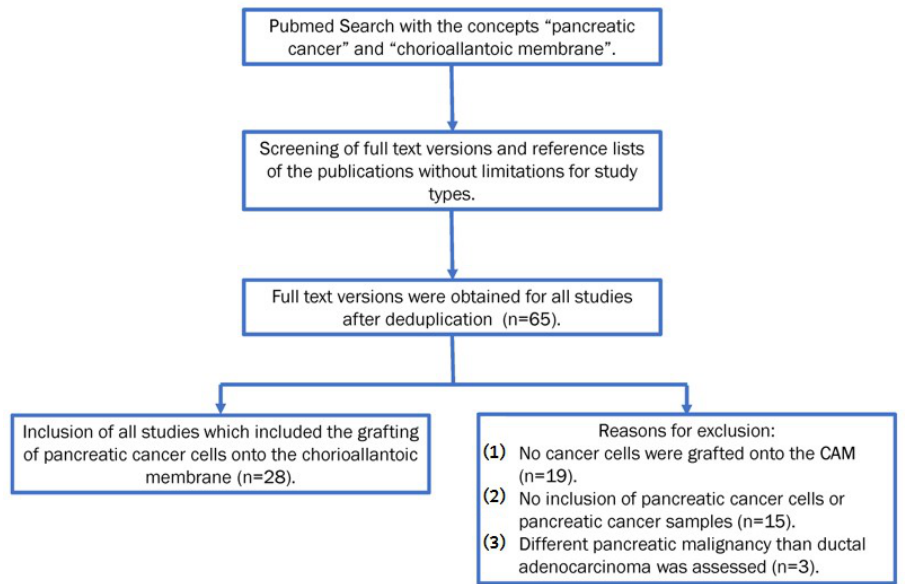
Figure 2. Flowchart illustrating the selection of in- or exclusion of